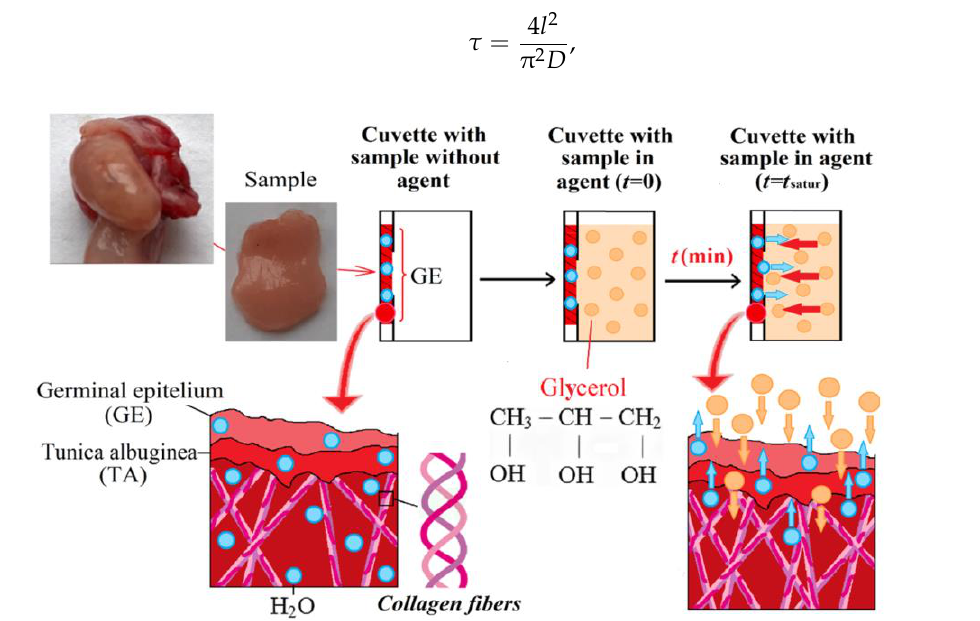
Figure 4. Diagram showing the interaction of a hyperosmotic agent (glycerol) with ovarian